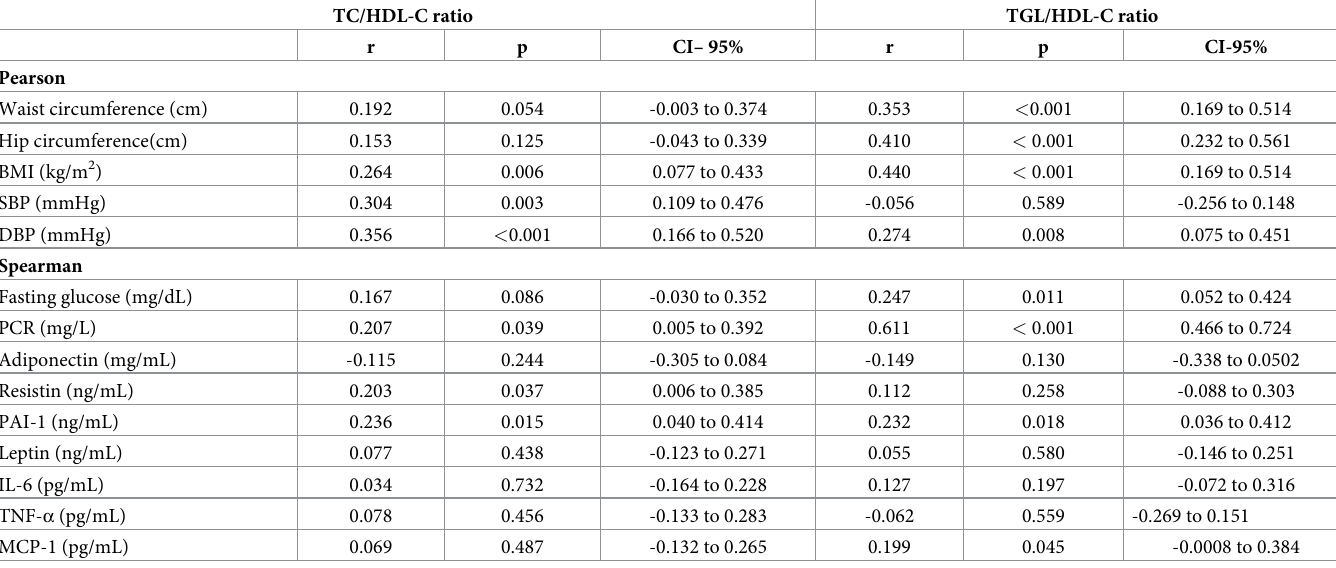
Table 3. Correlation between TGL/HDL-C and TC/HDL-C ratios with